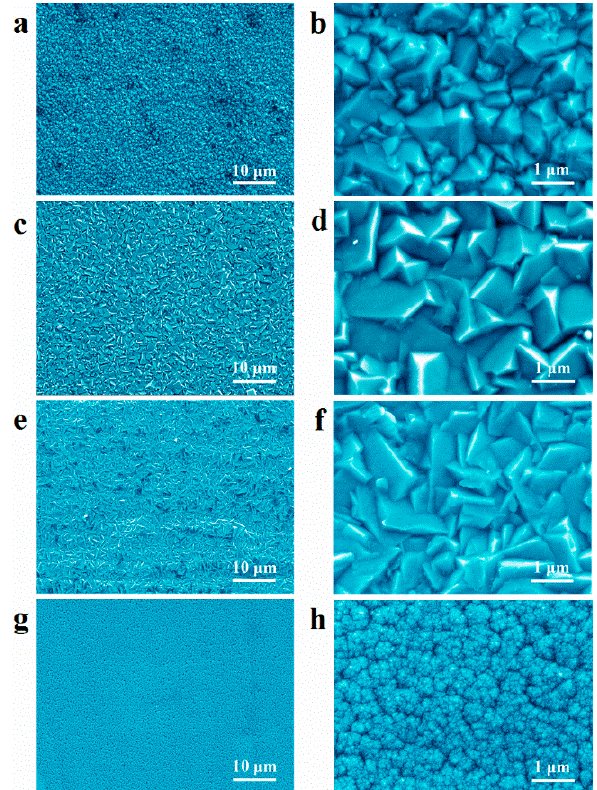
Figure 2. SEM images obtained for the ( a , b ) Al-Mn-BK, ( c , d ) Al-Mn-HP, ( e , f ) Al-Mn-PA, and ( g , h ) Al-Mn-CP coatings. ( a , c , e , g ) are the corresponding SEM images of coated samples at a 2000× magnification, ( b , d , f , h ) are the corresponding SEM images of the coated samples at a 20,000× magnification.